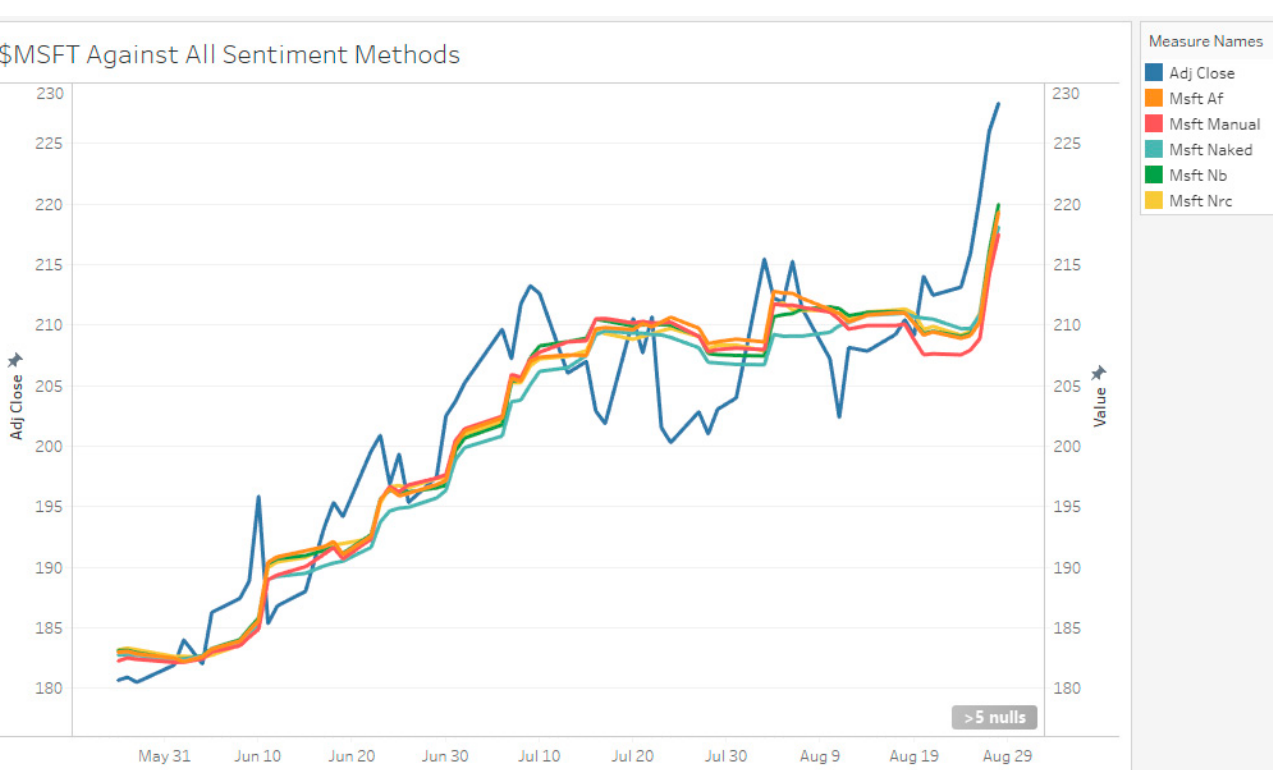
Figure 15. All SA-LSTM Model Comparison—MSFT.